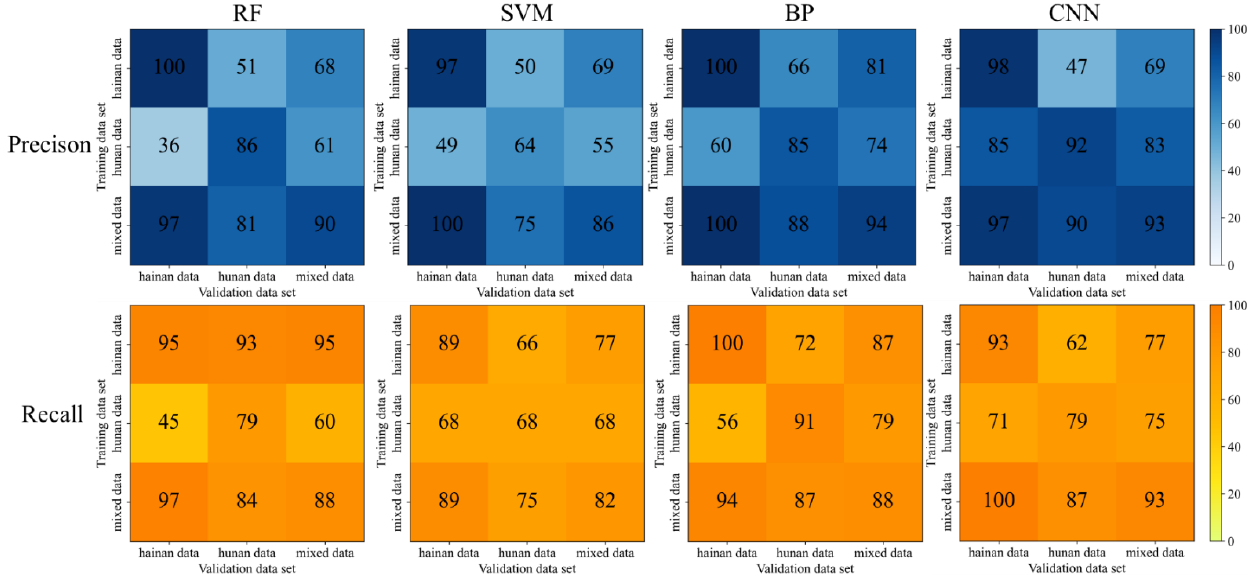
Figure 8. Evaluation results of each algorithm before dimensionality reduction.